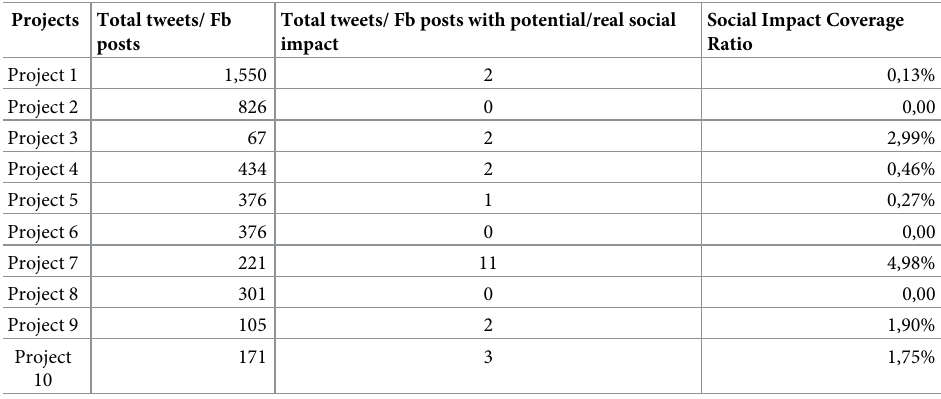
Table 12. Social impact coverage ratio per